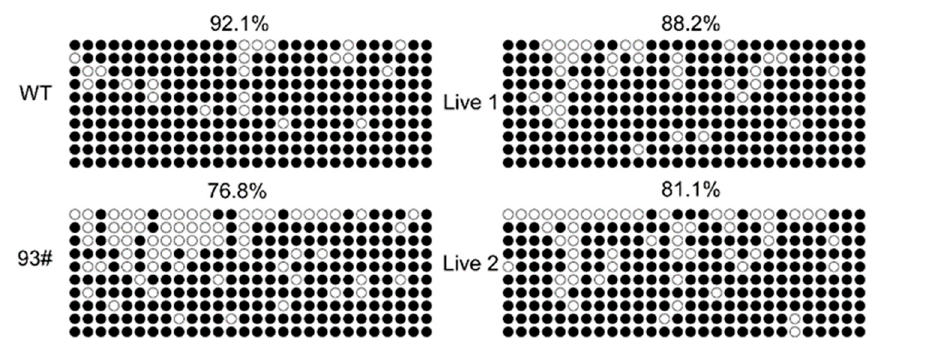
Figure 5. IGF2 methylation status in stillborn cloned cattle: Methylation levels of IGF2 DMR in wild-type cattle, stillborn cloned cattle, and live cloned cattle. WT represents wild-type cattle; 93# represents stillborn cloned cattle; Live 1 and Live 2 represent live cloned cattle. Each circle represents CpG dinucleotides. The methylation level (%) was based on the percentage of methylated CpGs in all examined CpGs; open circles represent no methylation and filled circles represent methylation. Table 2. In vivo development of NT embryos derived from single-cell clones 93 and 135. Donor Cells